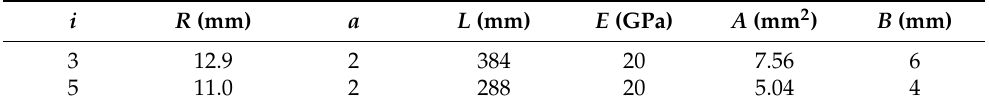
Table 4. The parameters of the timing belts.